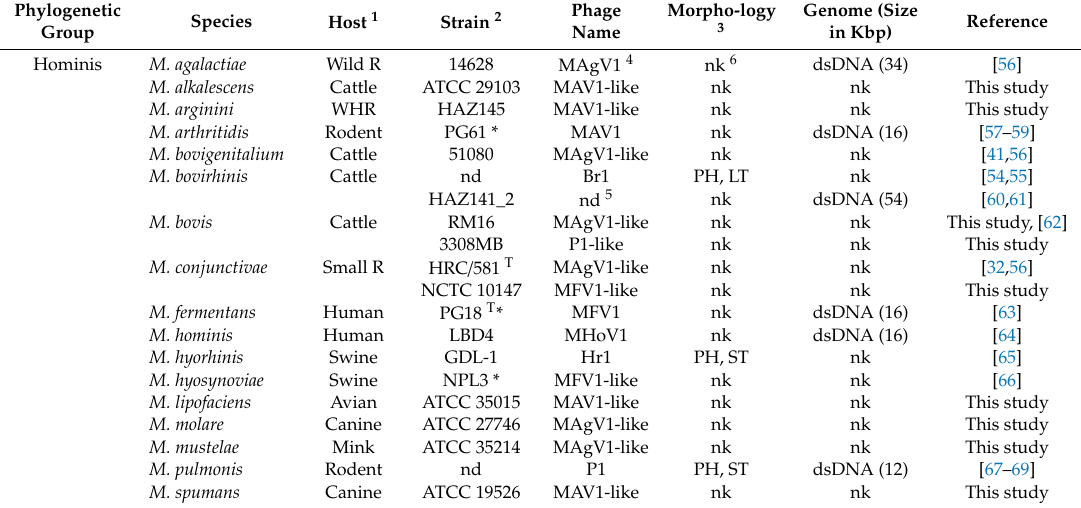
Table 2. Mycoplasma phages and